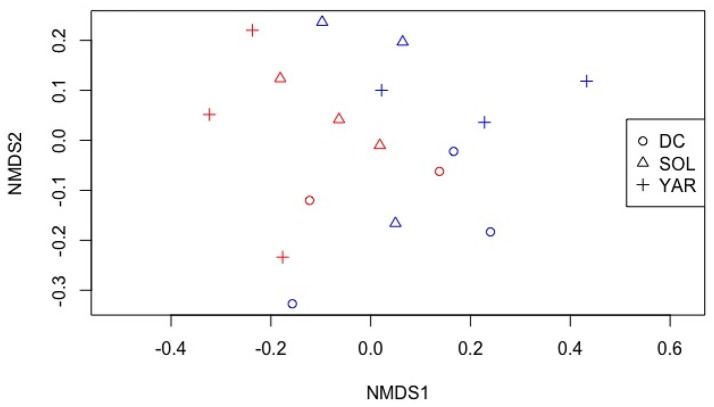
Non-metric multidimensional scaling of TRFLP profiles of bacterial endophytic communities from different plant species. Stress: 0.14. DC- Daucus carota (Wild carrot) SOL- Solidago canadensis (Goldenrod) YAR- Achillea millefolium (Yarrow). Red color- contaminated site Blue color- non-contaminated site.